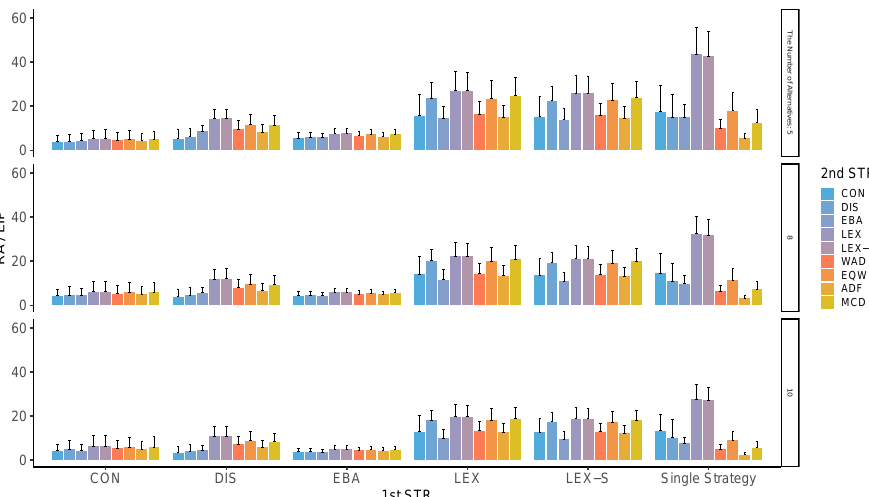
Figure 3. Efficiency rates (relative accuracy ( RA )/elementary information processes (EIP)) in two- stage decision-making when the number of alternatives left in the second stage is two for the different number of alternatives. Note: ADF: additive difference; CON: conjunctive; DIS: disjunctive; EBA: elimination by aspects; EQW: equal-weighted strategy; LEX: lexicographic; LEX-S: lexicographic semi-order; MCD: majority of confirming dimensions; STR: strategy; WAD: weighted